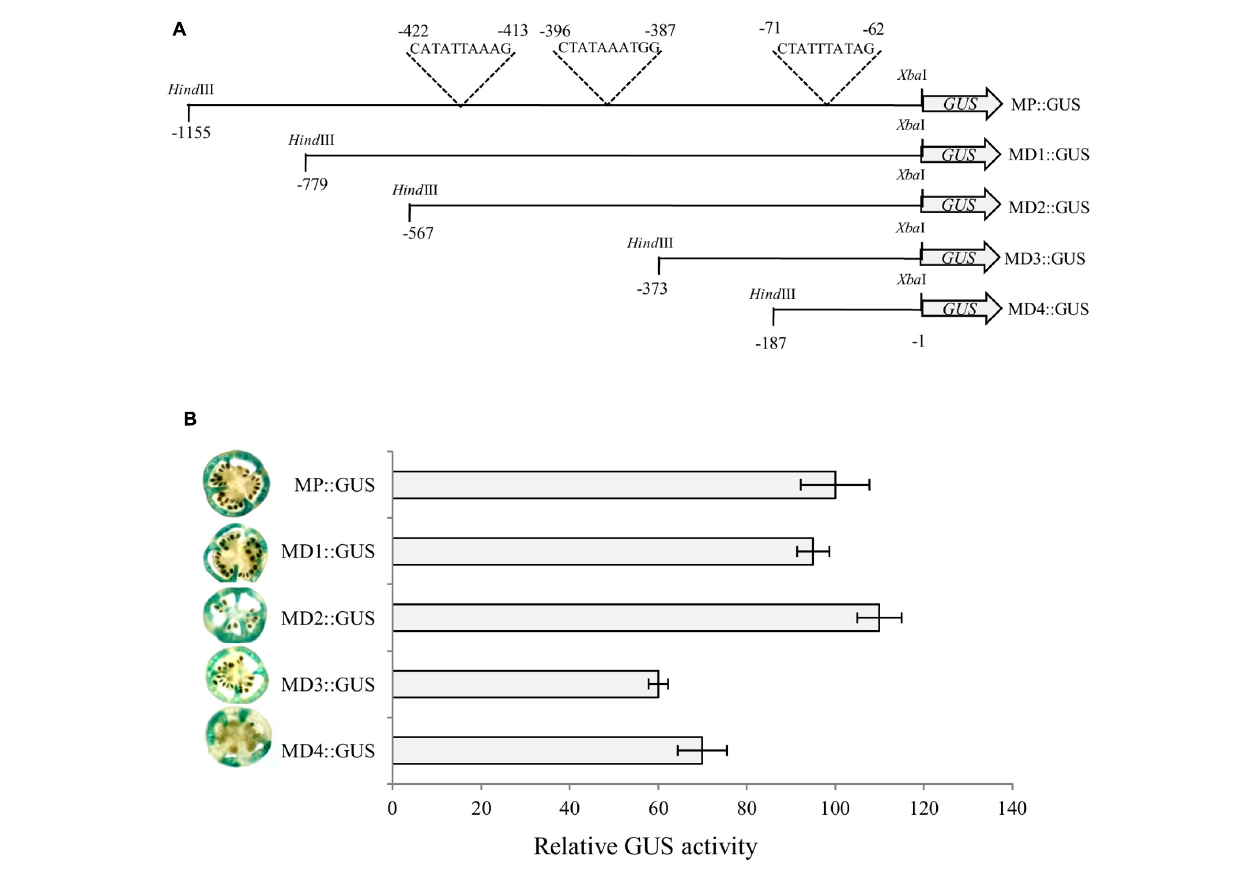
FIGURE 4 | Deletion analysis of α -Man promoter. (A) Schematic representation of promoter deletion constructs. 187, 373, 567, and 779 bp regions upstream of translational start site were cloned into pBI121 binary vector in place of CaMV35S promoter to generate GUS fusion constructs (MD4::GUS, MD3::GUS, MD2::GUS and MD1::GUS respectively). (B) Analysis of promoter driven expression of GUS . Histochemical and fluorometric GUS assays were carried out in fruits after Agrobacterium -mediated transient expression. Data are presented as the mean ( ± SE) from three biological